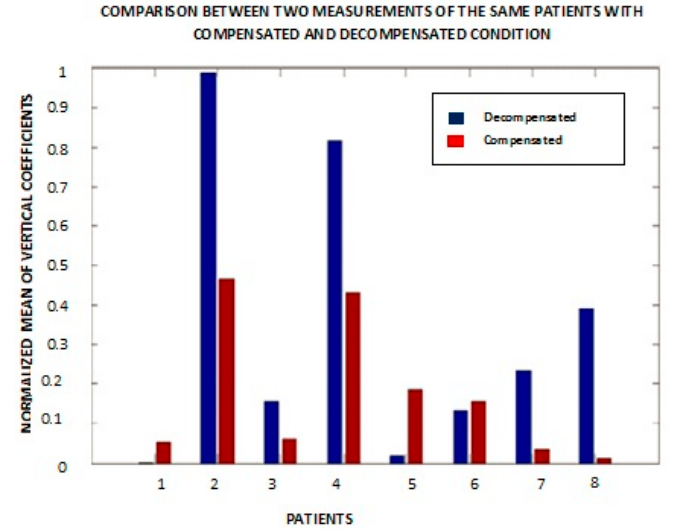
Figure 8. Comparative results of short duration heart signals for the same patient for the decompensated state (blue bars) and the compensated state (red bars) for patients numbered 1 to 8.